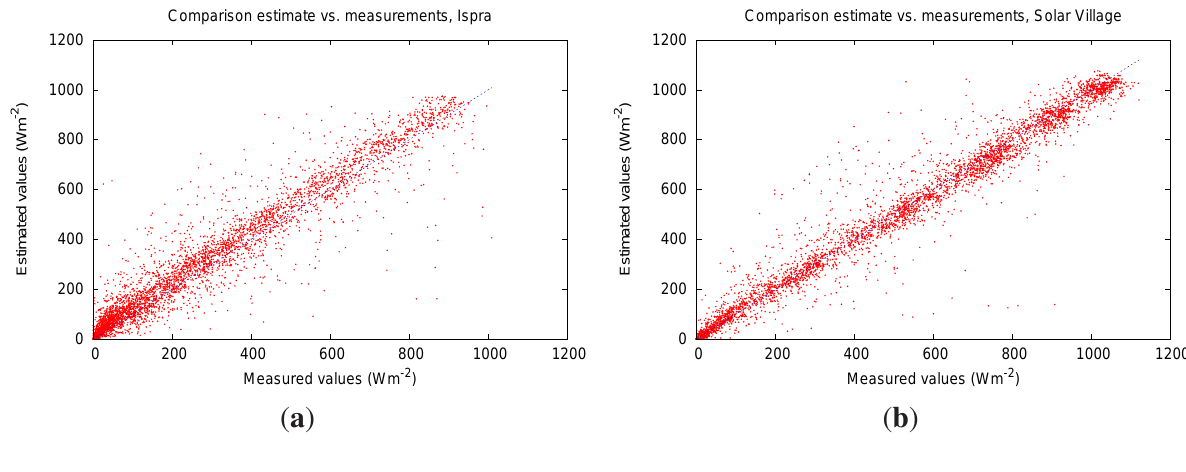
Figure 1. Two examples of scatterplots comparing measured and estimated values of G . ( a ) Station in Ispra, Italy; ( b ) Station at Solar Village, Saudi Arabia. The solid line represents the diagonal y = x